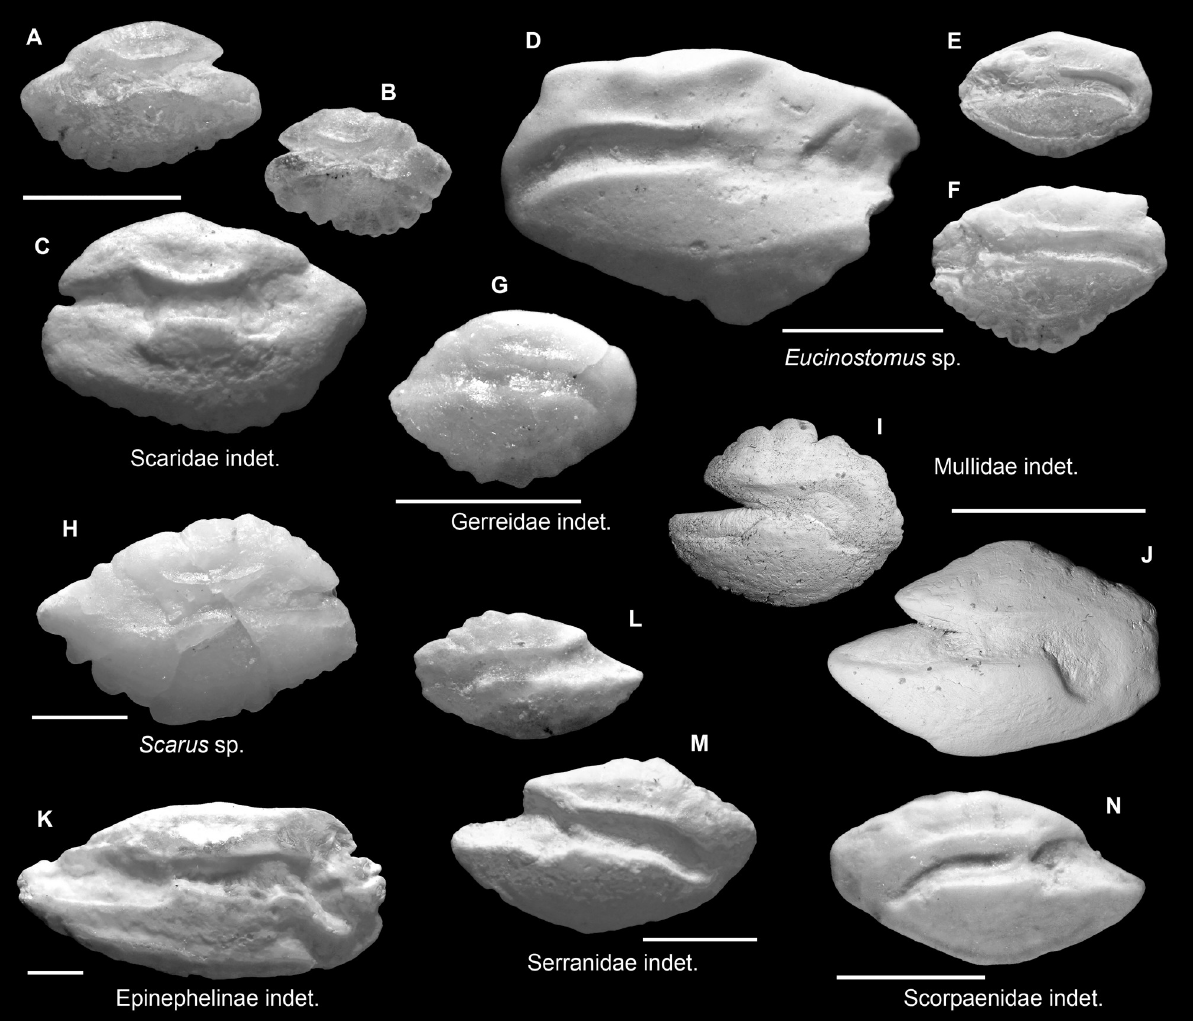
Fig 7. Fish otoliths from the mid-Holocene and sub-Recent reef sediments. Images are inner views and scale bars = 1 mm. A-C. Scaridae indet., A, left otolith, mid-Holocene, Sunset Point; B, right otolith, sub-Recent, Cayo Adriana; C, right otolith, sub-Recent, Punta Caracol. D-F. Eucinostomus sp., D, left otolith, sub-Recent, Cayo Adriana; E, F, right otoliths, mid-Holocene, E, Sweet Bocas Trench 3; F, Sunset Point. G. Gerreidae indet., right otolith, mid-Holocene, Sweet Bocas Trench 3. H. Scarus sp., left otolith, mid-Holocene, Sweet Bocas Trench 6. I, J. Mullidae indet., right otoliths, sub-Recent, I, La Caleta Beach Reef; J, Hickory Ship, La Caleta. K. Epinephelinae indet., right otolith, mid-Holocene, Ca ñ on los Rios. L, M. Serranidae indet., sub- Recent, Cayo Adriana, L, left otolith; M, right otolith. N. Scorpaenidae indet., left otolith, sub-Recent, Cayo